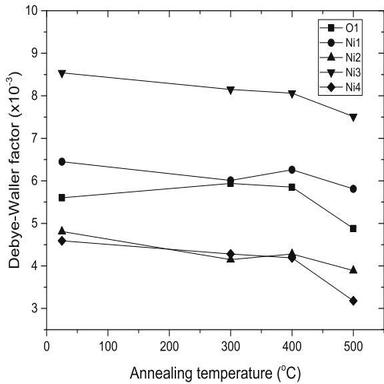
Debye-Waller factors for major coordination shells vs. annealing temperature for a 1700-nm-thick NiO film (Sample 1) in as-deposited state and after annealing at the stated temperatures. Data points were connected by straight lines for clarity.